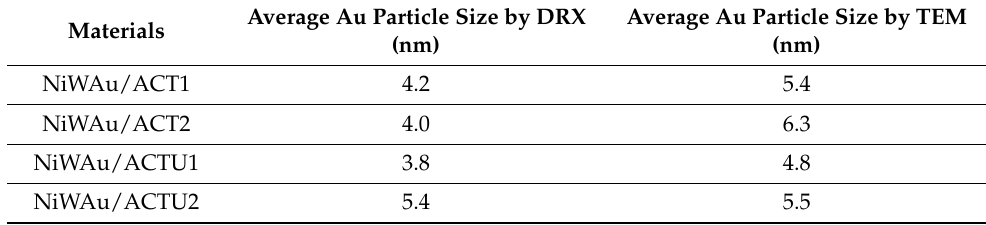
Table 3. Au particle size from XRD and TEM